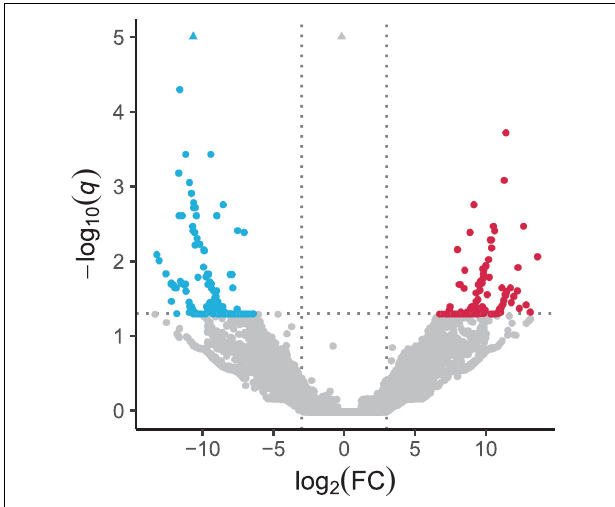
FIGURE 2 | Volcano plot depicting transcriptomic change in response to heat stress. Significantly upregulated and downregulated transcripts are indicated by red and blue dots, respectively. Horizontal dotted line represents the FDR-adjusted p -value ( q -value) = 0.05, and vertical dotted lines represent the absolute value of log 2 (fold change) = 3. Triangles represent transcripts with q -value < 10 − 5